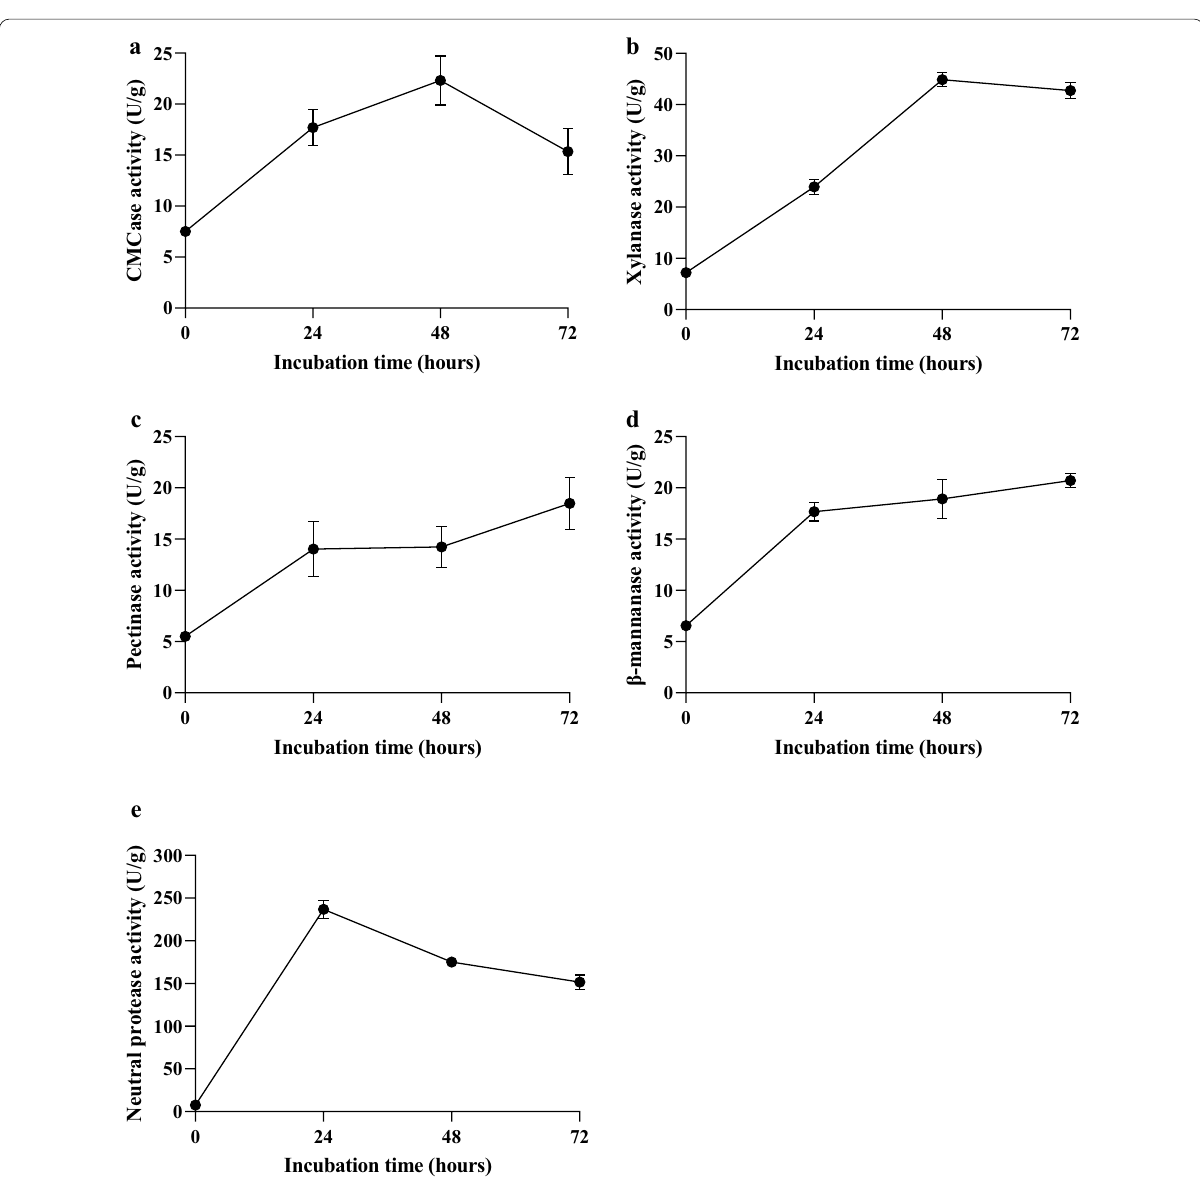
Fig. 2 Production of cellulase ( a ), xylanase ( b ), pectinase ( c ), β-mannanase ( d ) and neutral protease ( e ) of uninoculated SBM and FSBM during two-stage